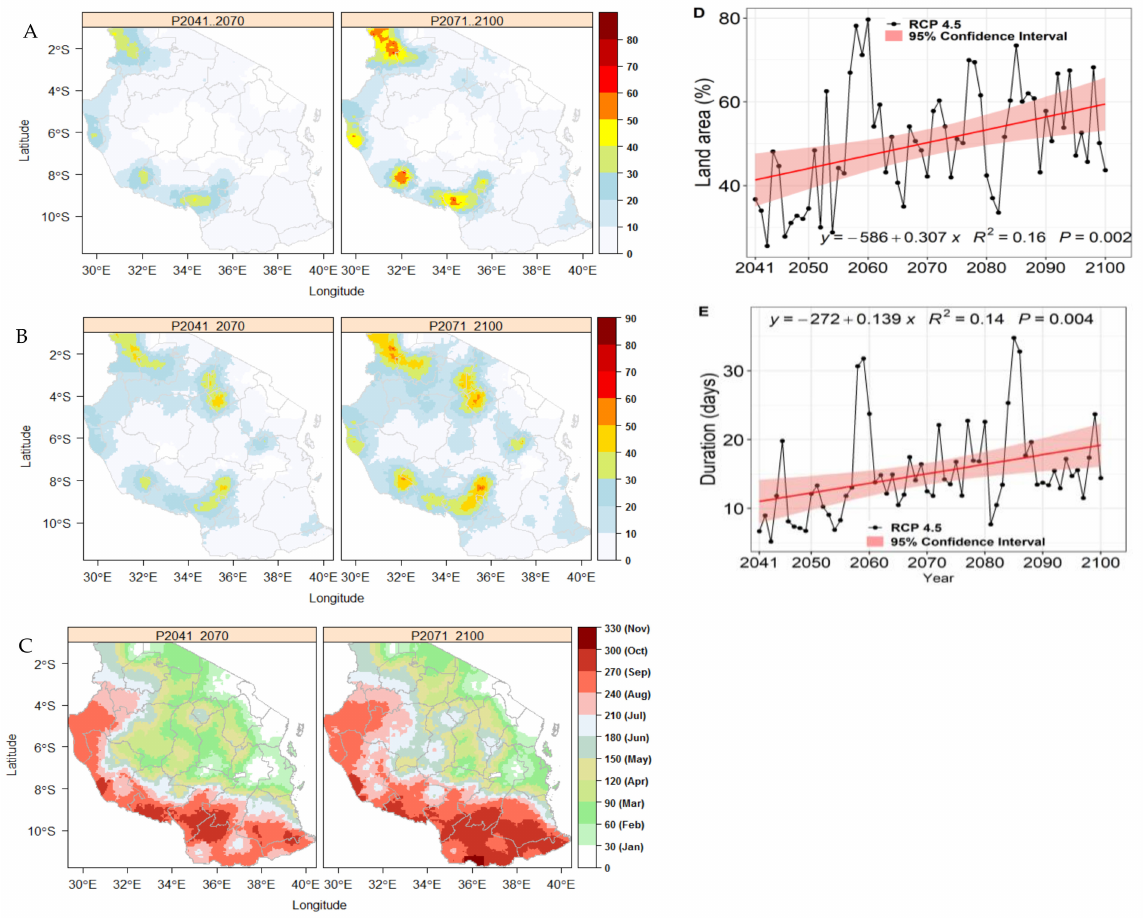
Figure 8. Projected changes of heatwave events in the 21st century ( A ) with their corresponding duration ( B ) and starting dates ( C ) averaged over Tanzania. Graph ( D ) represents the land area ratio ( E ) shows trends of the heatwave events that occurred in Figure